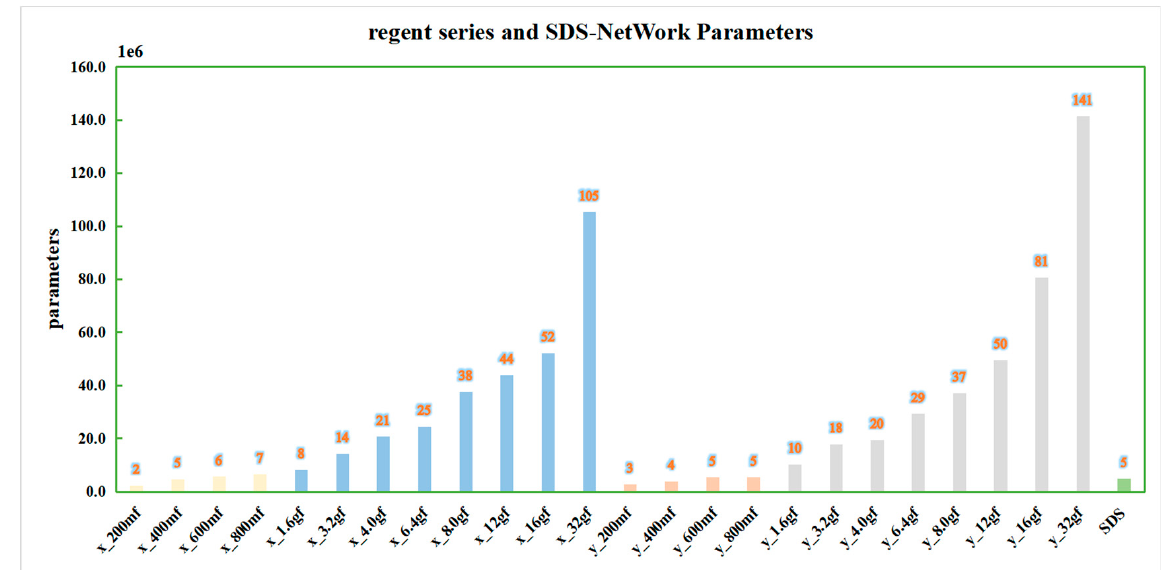
Figure 11. Parameter comparison of SDS-Network and regnet algorithm.